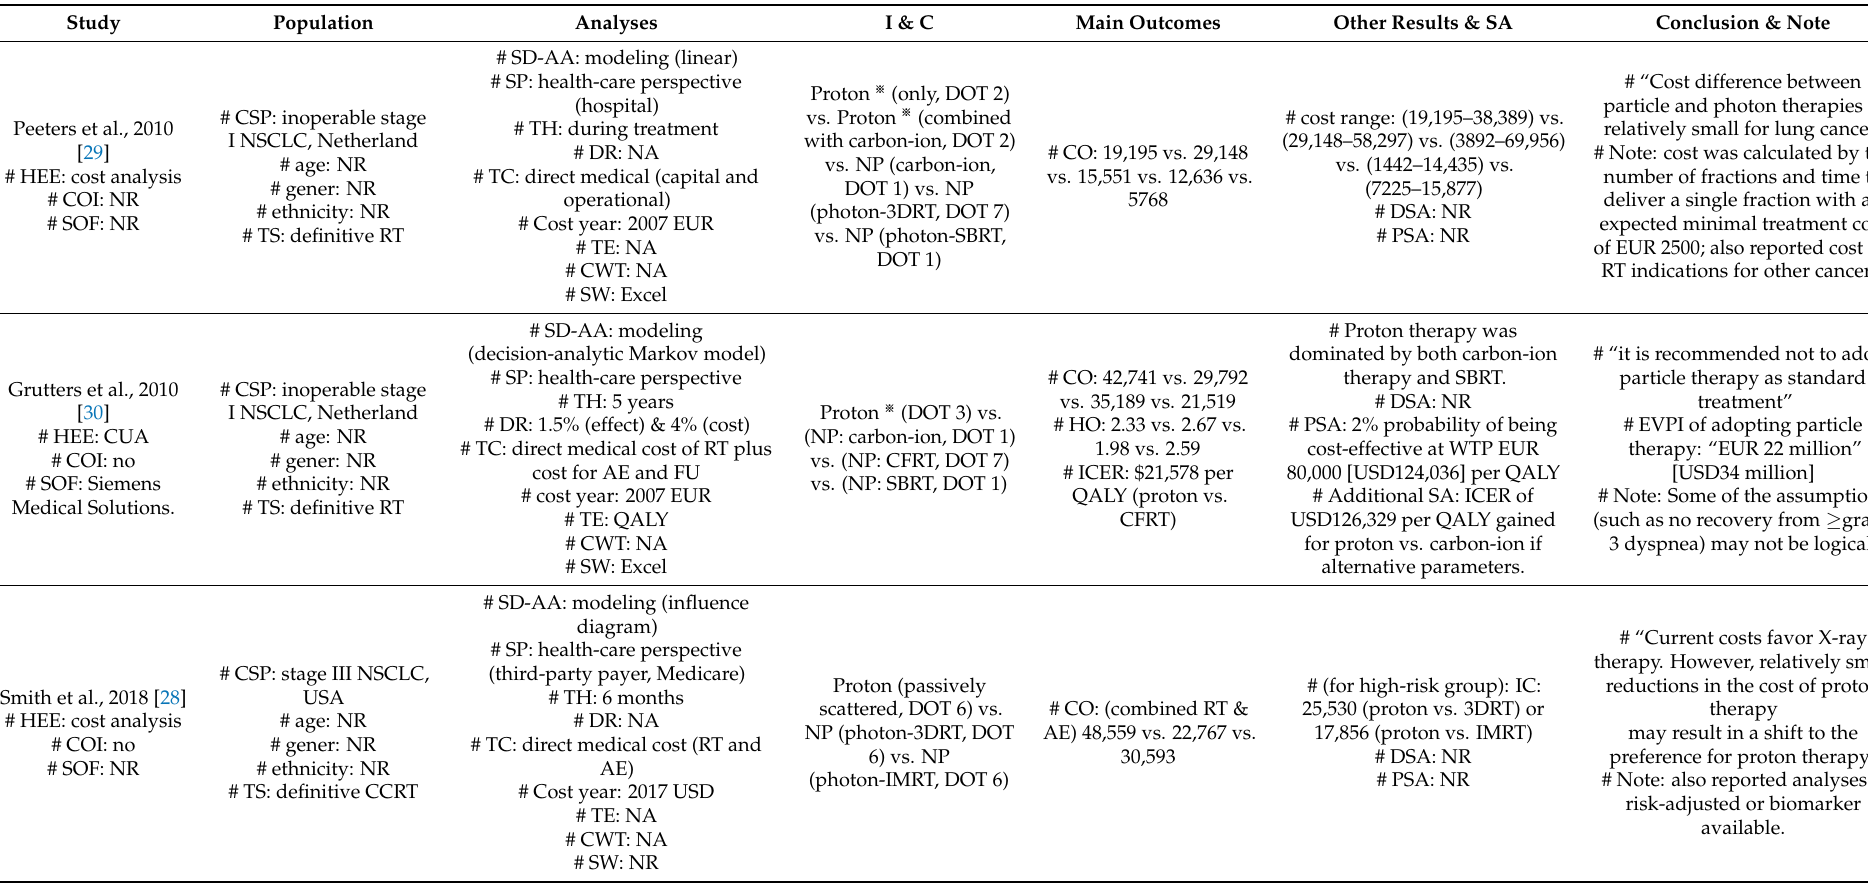
Table 1. Summary table of the included health economic evaluations